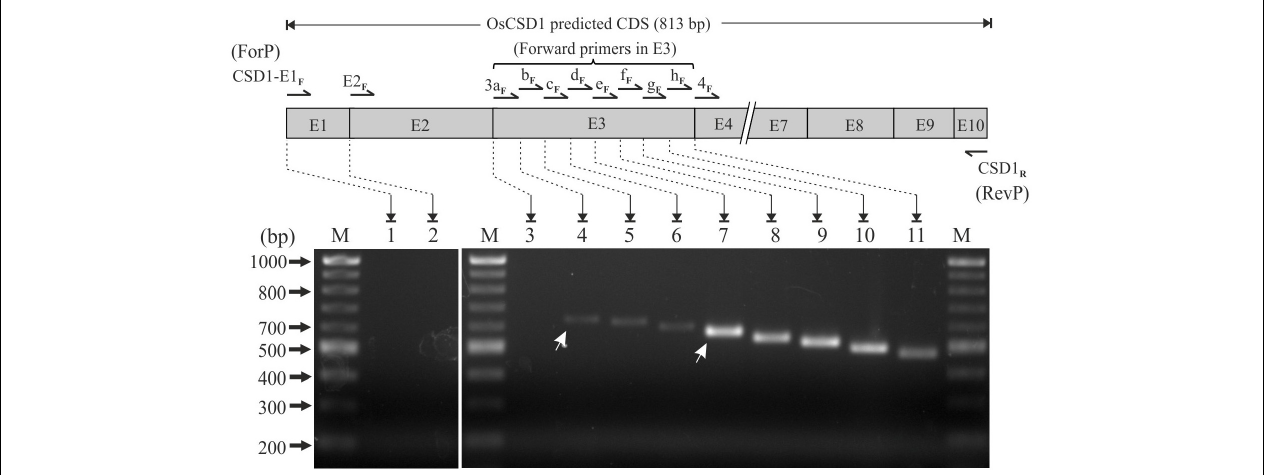
FIGURE 2 | RT-PCR-based analysis of transcription status of OsCSD1 exon1, exon2, and fine mapping of exon3 (E3 box) using different forward and common reverse primers (CSD1 R ). Lane 1, CSD1-E1 F + CSD1 R ; lane 2, CSD1-E2 F + CSD1 R ; lane 3, CSD1-E3a F + CSD1 R ; lane 4, CSD1-E3b F + CSD1 R ; lane 5, CSD1-E3c F + CSD1 R ; lane 6, CSD1-E3d F + CSD1 R ; lane 7, CSD1-E3e F + CSD1 R ; lane 8, CSD1-E3f F + CSD1 R ; lane 9, CSD1-E3g F + CSD1 R ; lane 10,